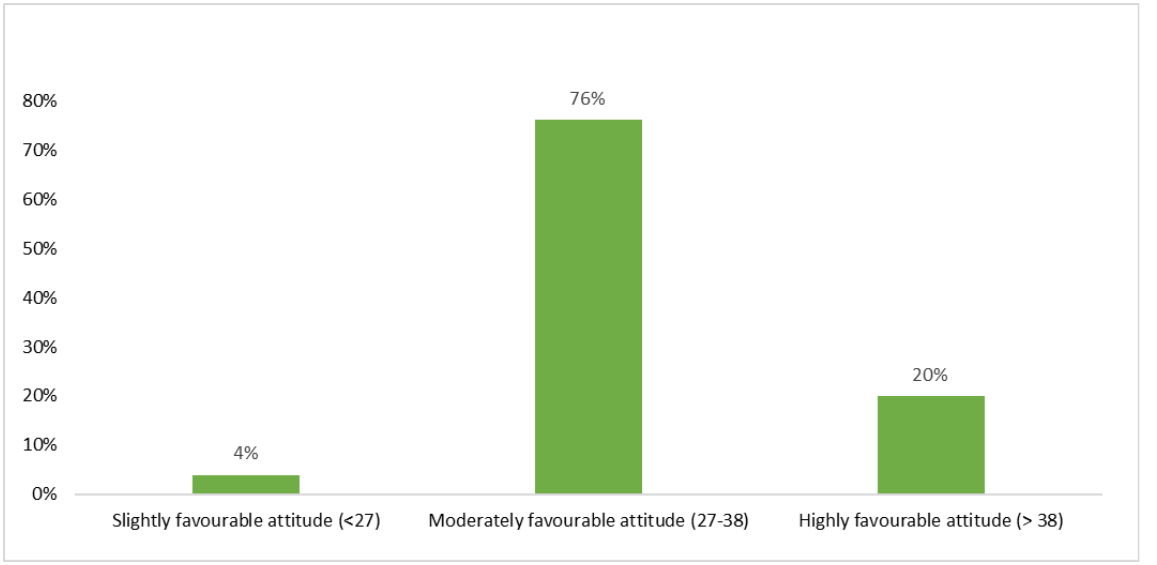
Figure 2: Attitude Toward the Application of Pesticides Table 2: Extent of Attitude Towards Individual Statement Regarding Chemical Pesticide Use